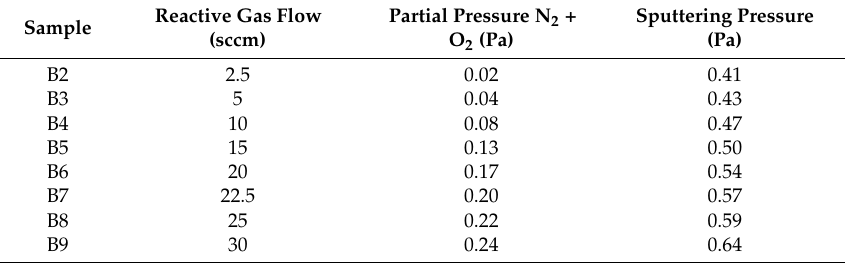
Table 1. Deposition parameters for the tantalum oxynitride